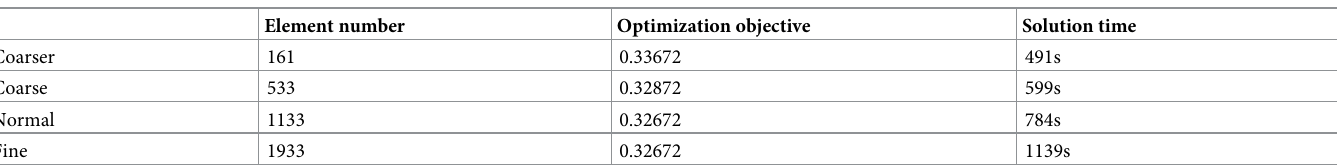
Table 2. Grid independent validation.